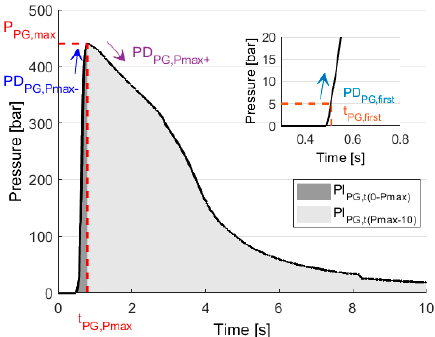
Figure 3. Illustration of the features extracted from the pressure curves.